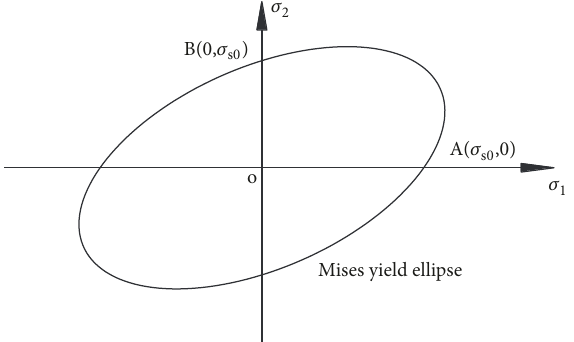
Figure 1: The von Mises yield criterion in 𝜎 2 − 𝜎 1 coordinate